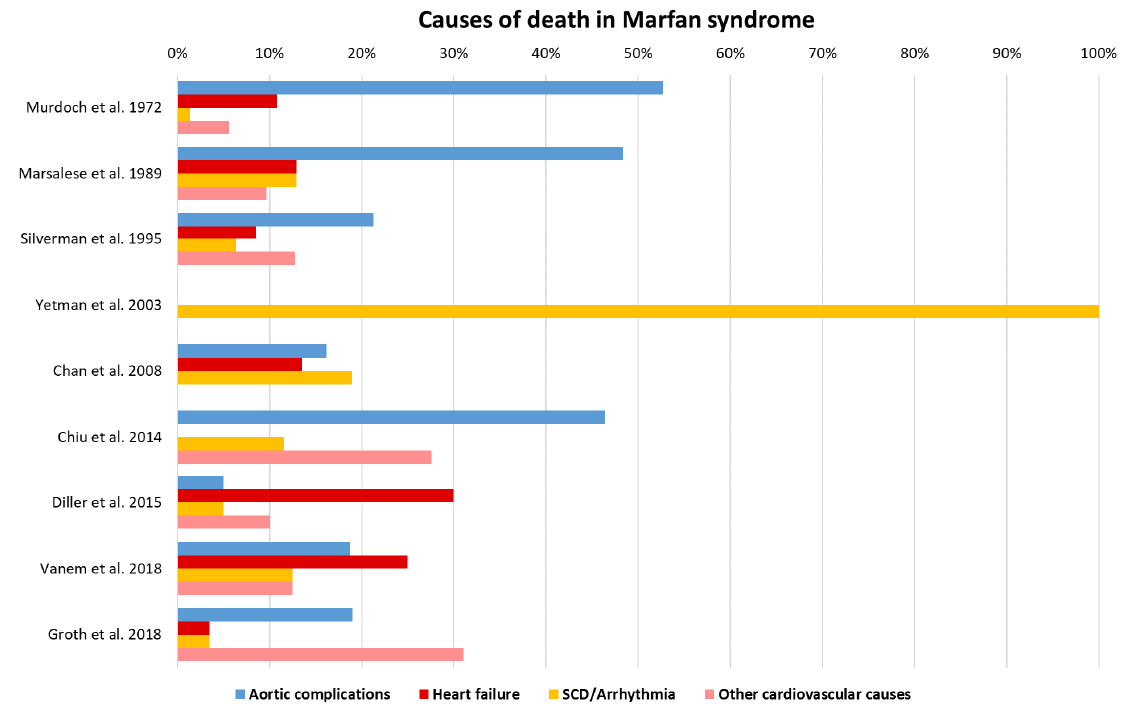
Figure 3. Overview of studies reporting causes of death in patients with MFS. SCD: Sudden cardiac death.